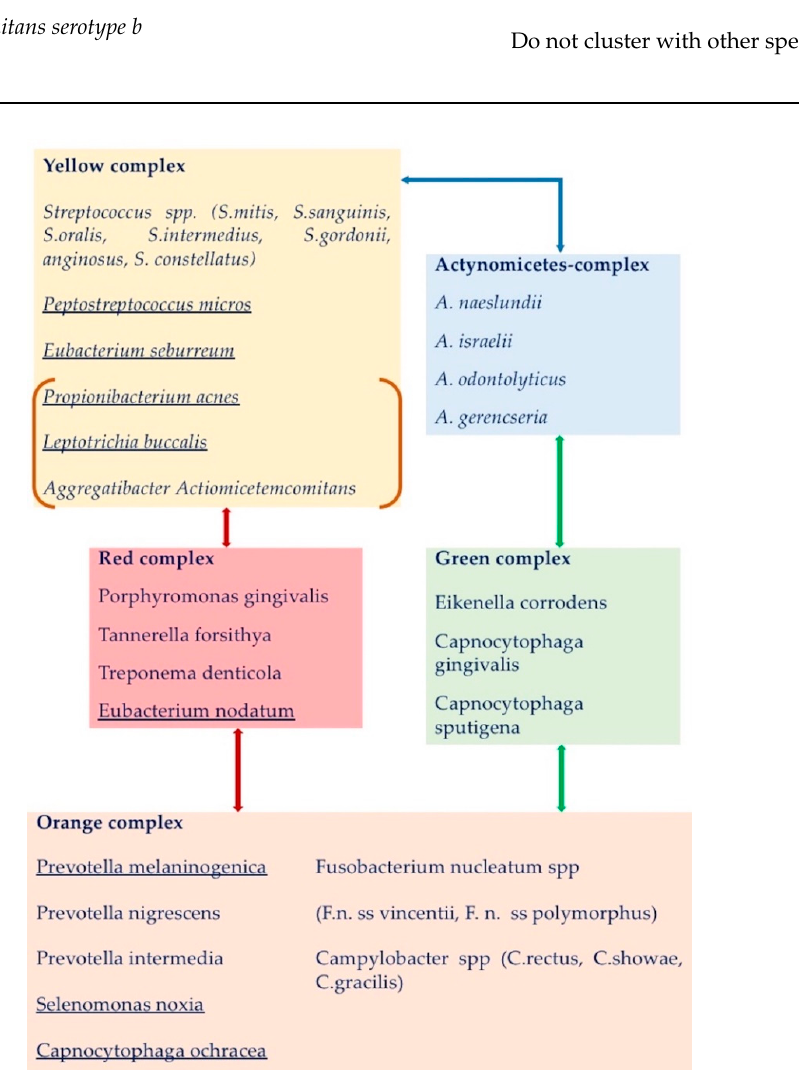
Figure 1. The periodontopathogen potential of each bacterial complex of the supragingival mature plaque and their relationships, according to Haffajee et al., 2008 [46]. The bacteria found in clusters different from the ones of the subgingival plaque are underlined. Actinomyces complex (in blue box) and the yellow complex were tightly associated. The red complex bacteria were associated with both the yellow and orange complexes. The green complex was interrelated with the Actinomyces spp. and the orange complex species. The bacteria in orange square brackets ( A. actinomycetemcomitans , P. acnes , and L. buccalis ) were occasionally found associated in the yellow complex. Neisseria mucosa and Veillonella parvula of the purple complex were not associated with other complexes, while Treponema socranskii and Gemellia morbillorum related to different clusters and are not